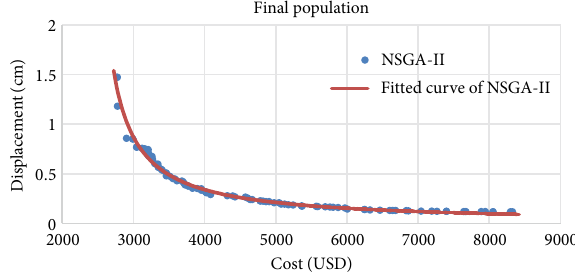
Fig. 4. Pareto-front obtained in the first